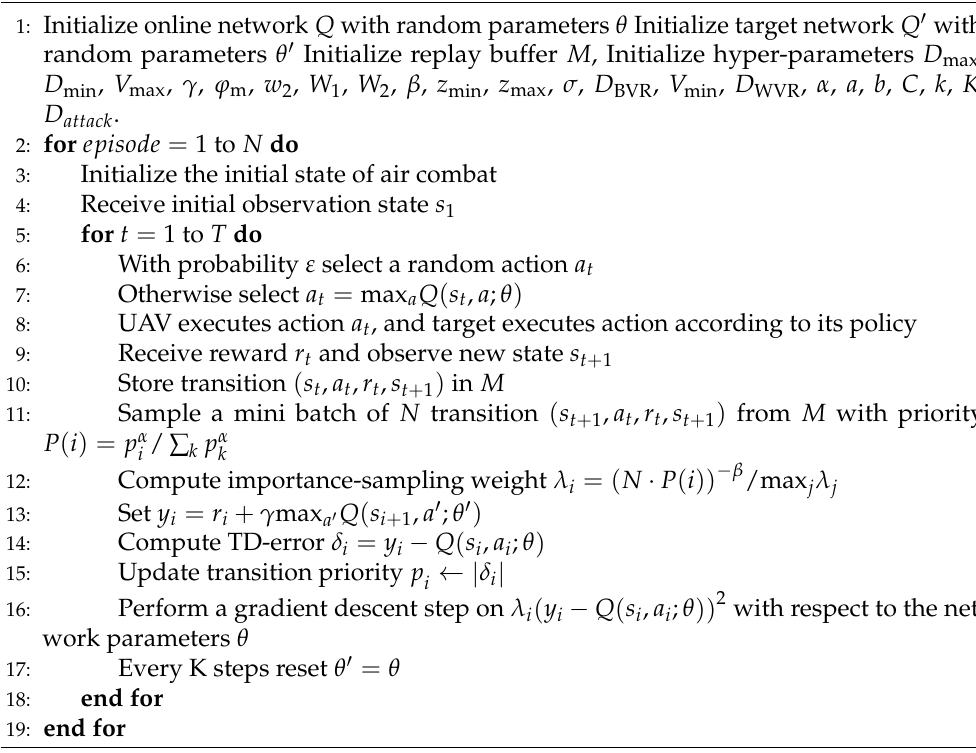
Algorithm 1 DQN with proportional